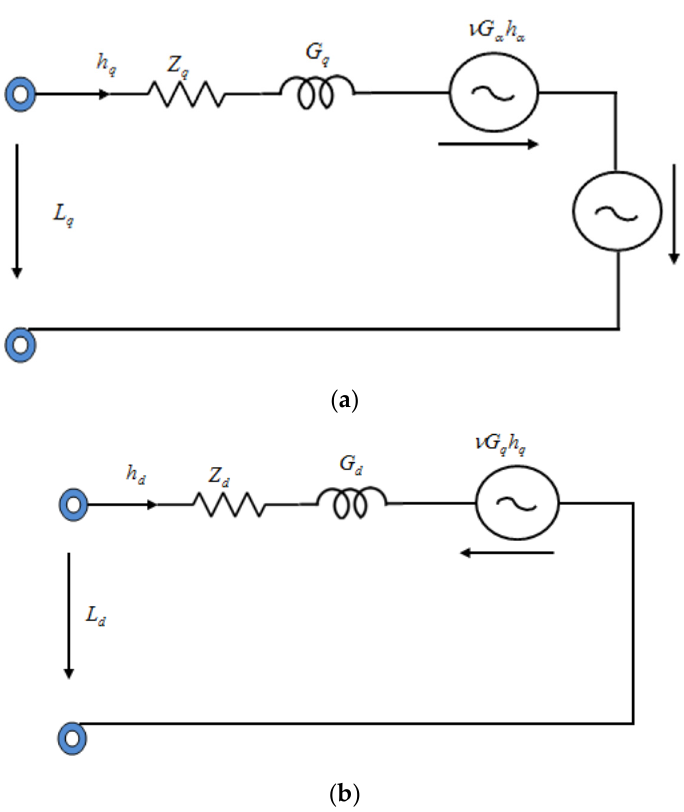
Figure 2. Equivalent circuit for ( a ) q -axis, and ( b ) d -axis. Across the IPM synchronous generator, the bidirectional power electronic switches are connected in the proposed method, as displayed in Figure 3.